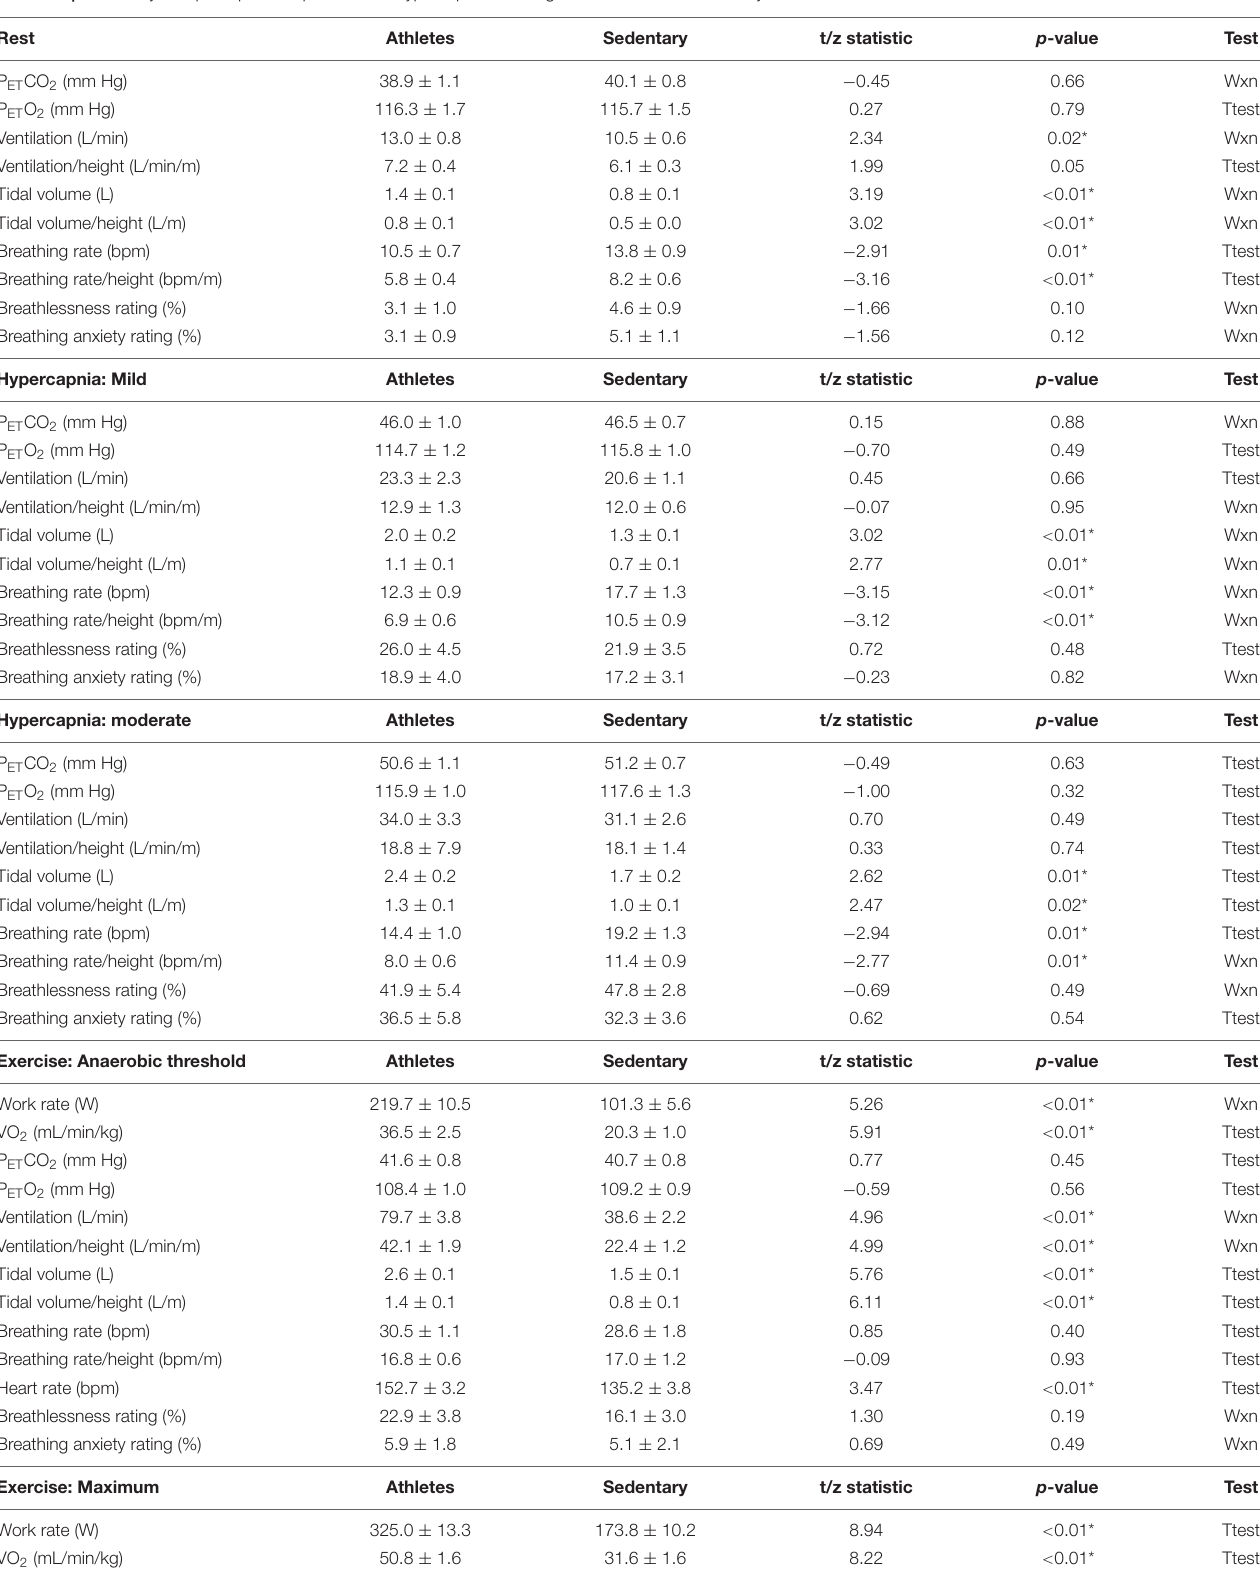
TABLE 2 | Ventilatory and perceptual responses to a hypercapnic challenge for athletes and sedentary controls. Rest Athletes Sedentary t/z statistic p